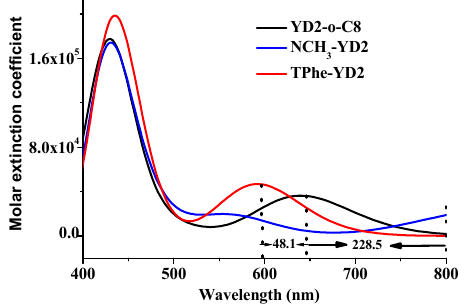
Figure 5. The simulated absorption spectra of studied dyes obtained by B3LYP method in THF media. From Figure 5, YD2-o-C8 displays an intensity B band at 436.0 nm and a weak Q band at 640.3 nm.